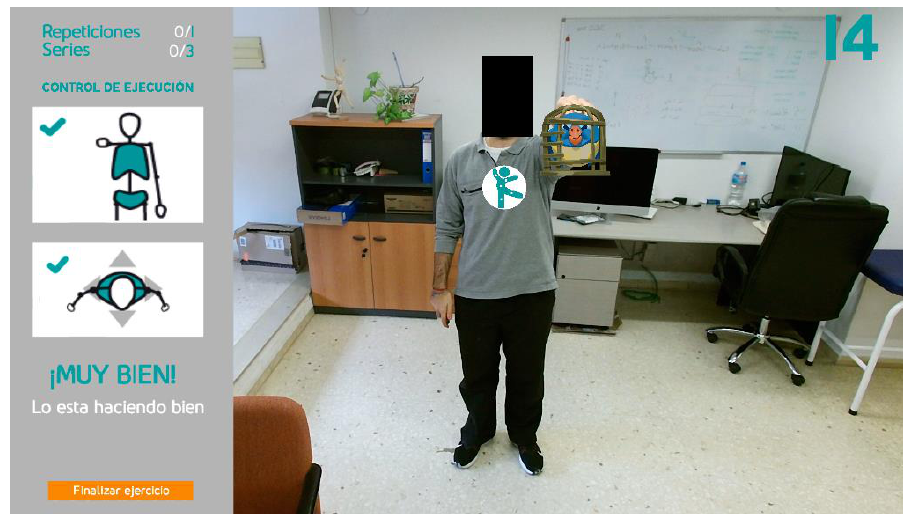
Figure 6. An Augmented Reality (AR) element embedded in a gamified environment: put the bird into the cage.